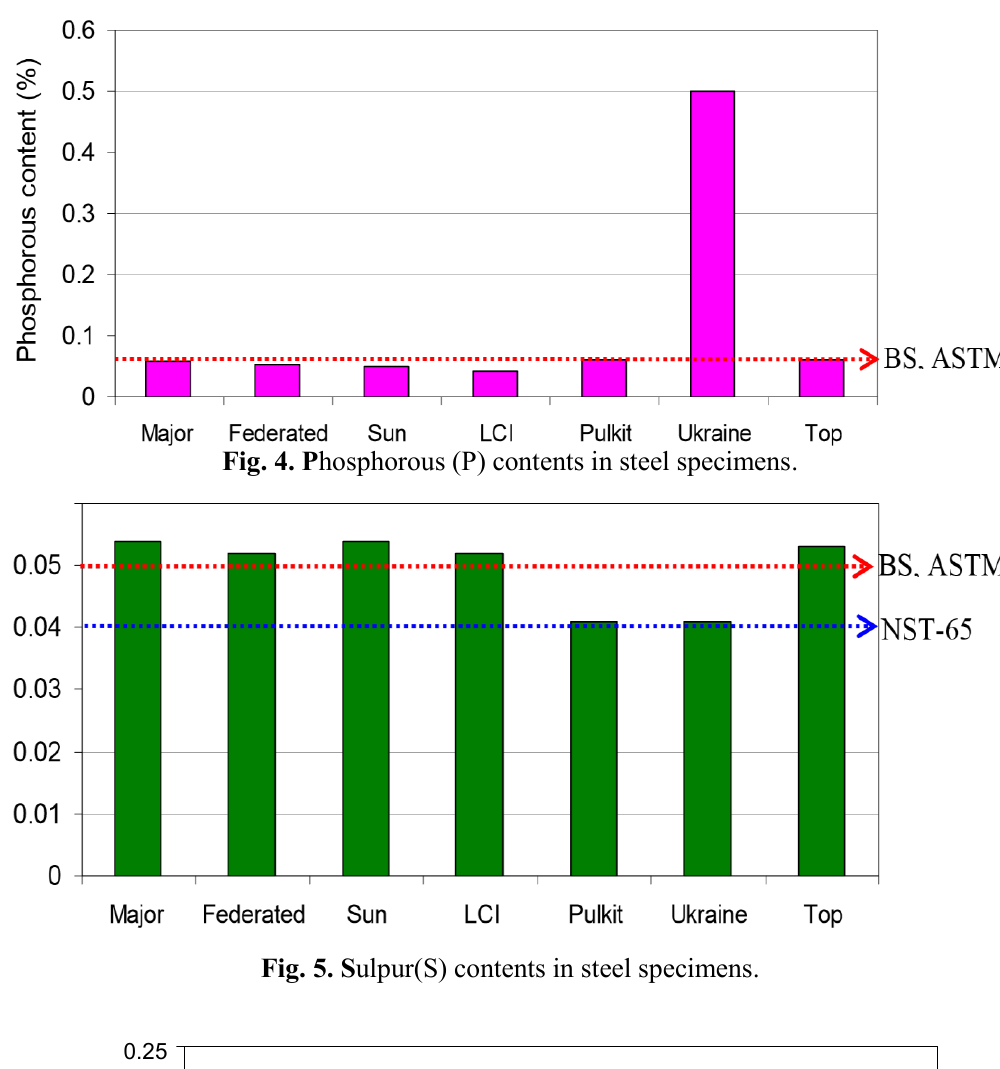
Fig. 5. S ulpur(S) contents in steel specimens.